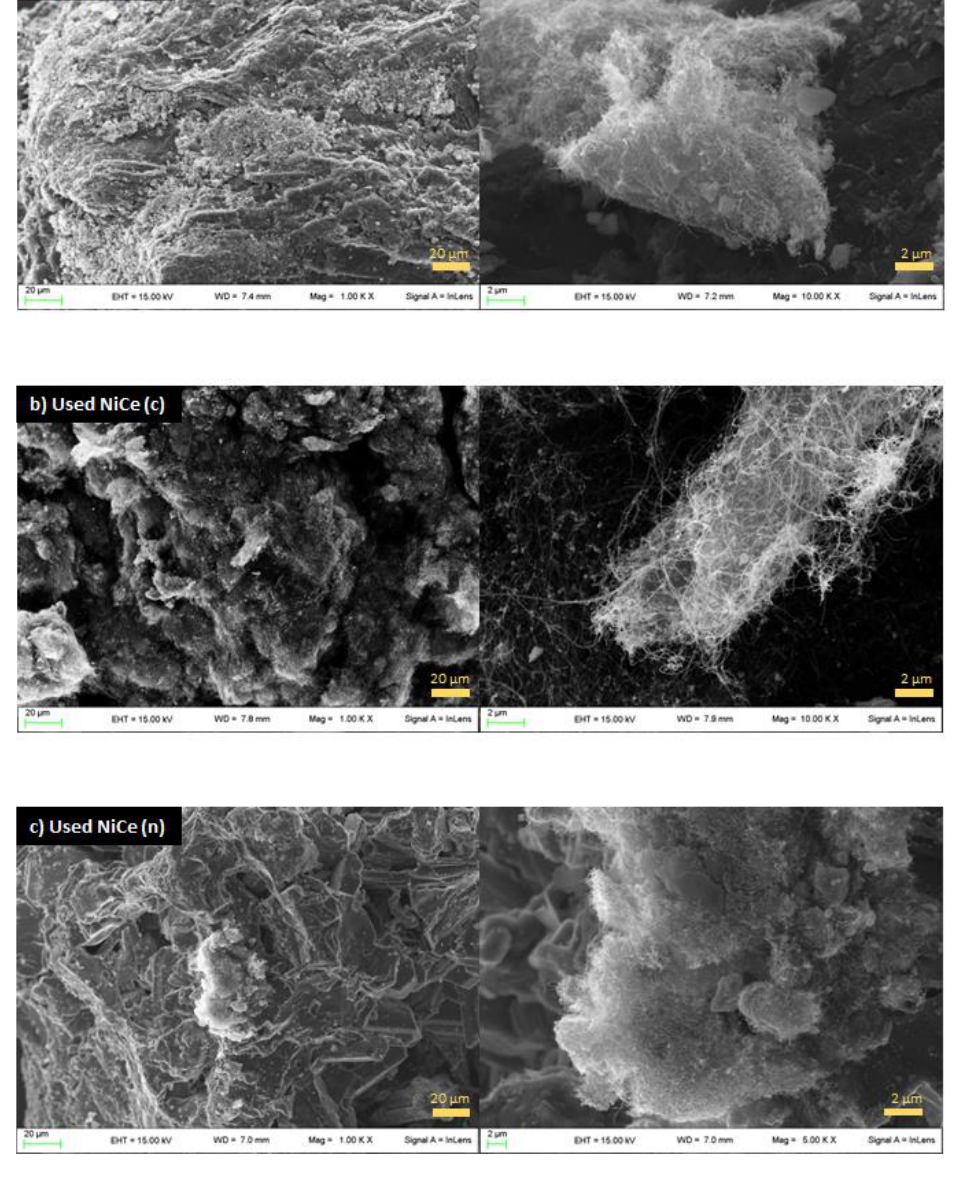
Figure 7. SEM analysis on spent catalysts: ( a ) used NiCe (i); ( b ) used NiCe (c); ( c ) used NiCe (n).